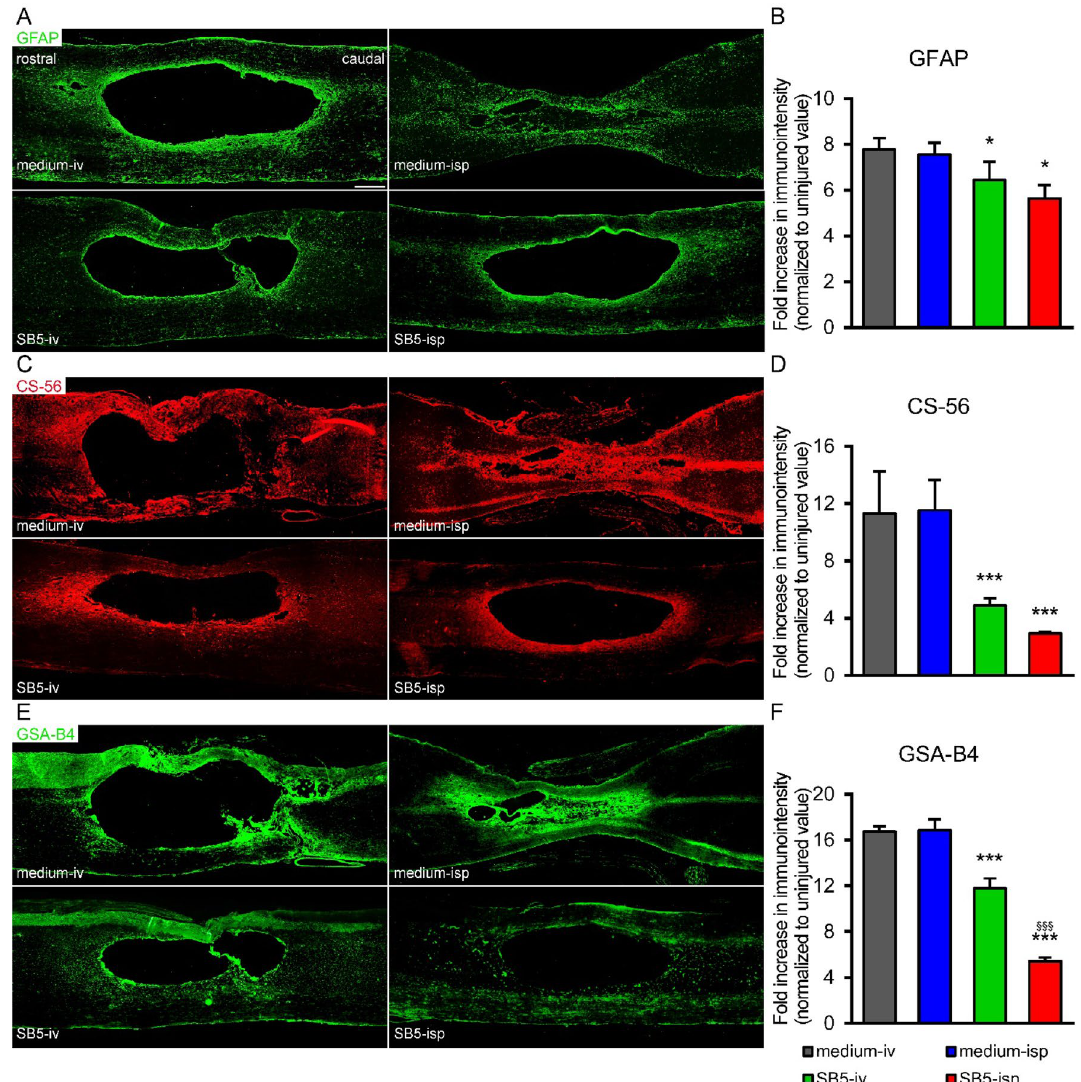
Figure 4. Modulation of the lesion environment. ( A , C , E ) Low magnification images of parasagittal spinal cord sections show the GFAP, CS-56 and GSA-B4 reactivity 9 weeks after the injury around the lesion area in the various experimental groups. ( B , D , F ) Quantification of GFAP, CS-56 and GSA-B4 reactivities in the sagittal sections of the spinal cord revealed a decreased level of all examined markers in hiPSC-treated groups ( SB5-iv , SB5-isp ) compared with the control groups ( medium-iv , medium-isp ). Data are expressed as mean ± SEM (n = 4 in each group). * p < 0.05 *significant difference between the intraspinally ( SB5-isp ) or intravenously ( SB5-iv ) grafted animals and the control animals in B. *** p < 0.01 ***significant difference between the intraspinally or intravenously grafted animals with the control animals in D and F. §§§ p < 0.01 §§§ significant difference between the intraspinally grafted animals ( SB5-isp ) and the intravenously treated animals ( SB5-iv ) in D and F. Scale bar in A: 200